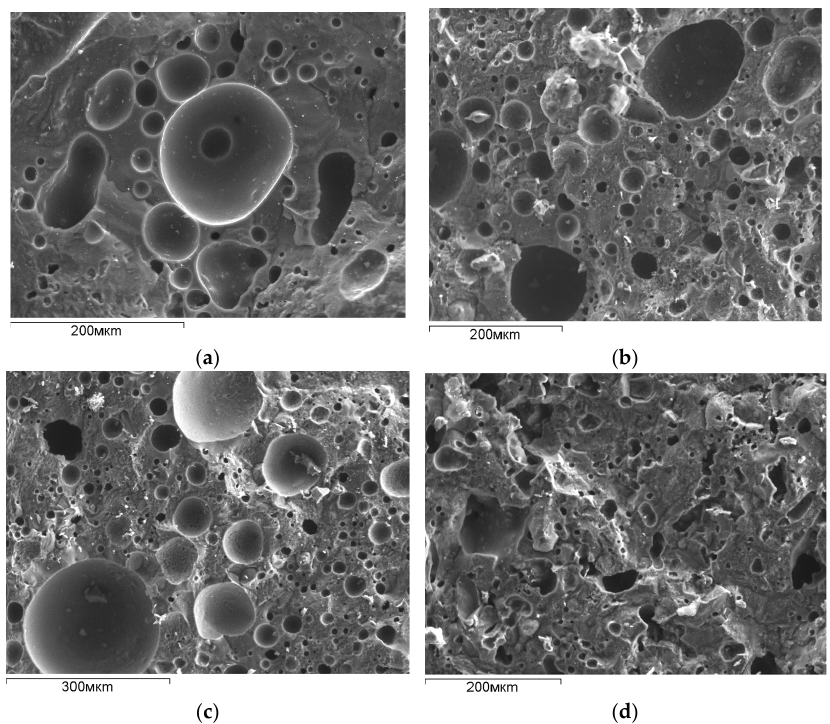
Figure 7. Electron microscopic photographs of the structure of samples after burning at 1170 ◦ C: ( a ) sample based on loam without additives. ( b ) Sample based on loam with 15% diatomite from the Zhalpak deposit. ( c ) Sample based on loam with 15% diatomite from the Utesai deposit. ( d ) Sample based on loam with 15%